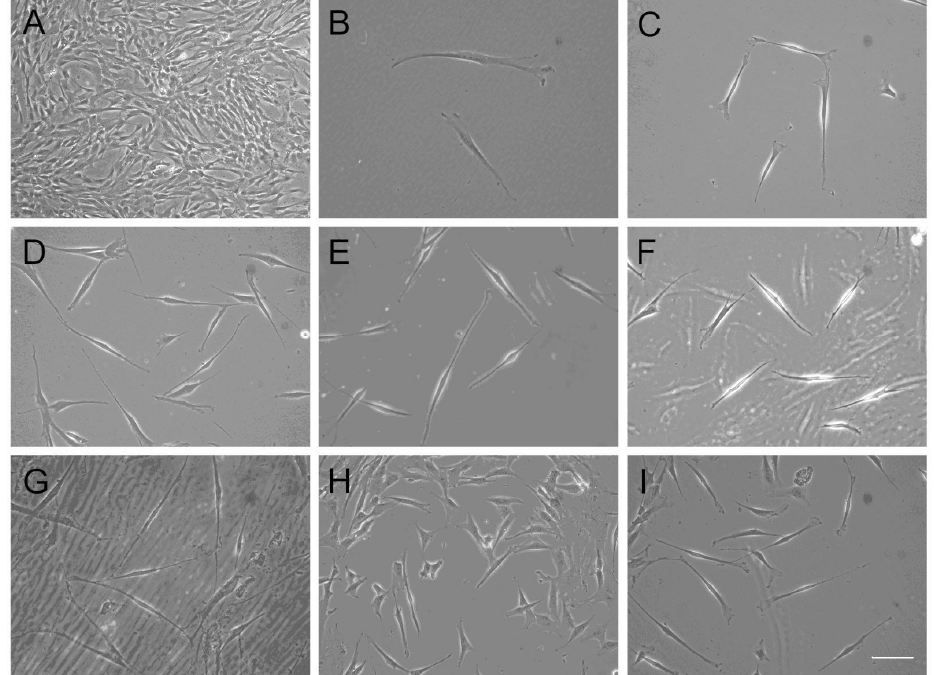
Figure 2. Morphological changes after Schwann cell (SC)-cell like cell induction. Undifferentiated human placenta-derived multipotent stem cells (PDMCs) at passage 4 exhibited fibroblast-like morphology under a phase contrast microscope ( A ). After incubation with β -ME, PDMCs began to elongate and left a contracted cell body with several process-like extensions ( B ). After incubation with RA, cells further retracted their cytoplasm to become spindle shaped and produced more obvious halations ( C ). After induction with neurotrophic and growth factors, human PDMCs differentiated into SC-like cells on days 5, 8, 11, and 14 ( D , E , F , G , respectively). A higher percentage of morphological change was exhibited from days 5–8 (D, E). SC-like cells retained their morphology on day 11 (F). Some SC-like cells failed to maintain their morphology and even died (G). Relationship between morphology and cell density; morphological changes of cells were less obvious in areas with a higher cell density ( H ) than in those with a lower cell density ( I ). Bar, 100 μ m.